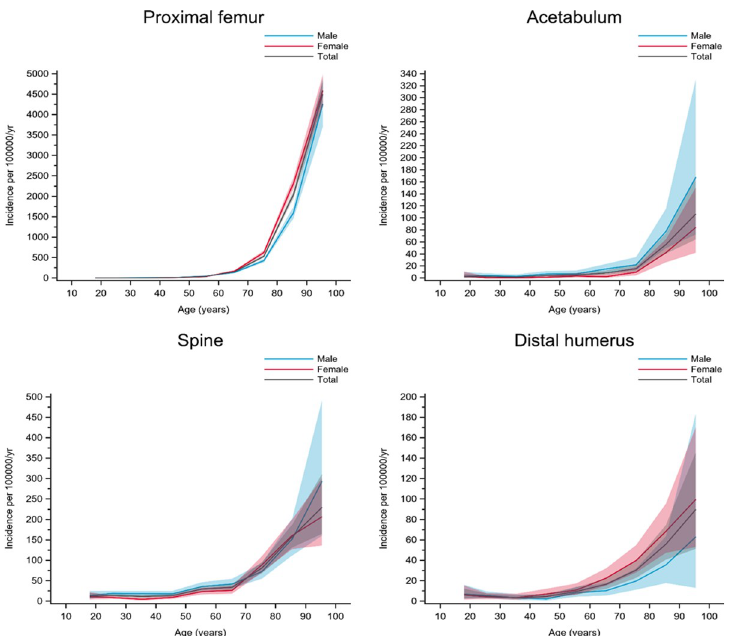
Fig 2. Fractures in group A. Age- and gender-specific incidence with 95% confidence interval. Black line represents the total population; red line represents females and blue line represents males.